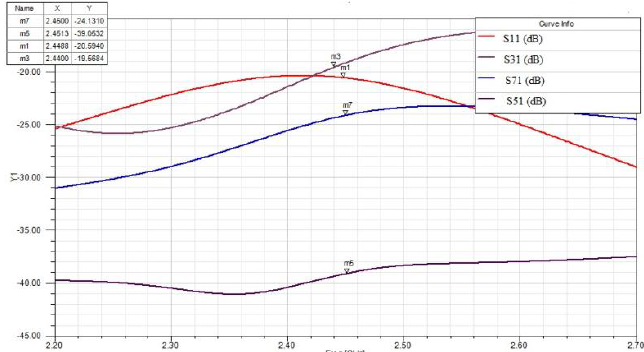
Figure 14. Simulated S –parameters (S 11 , S 31 , S 51 , S 71